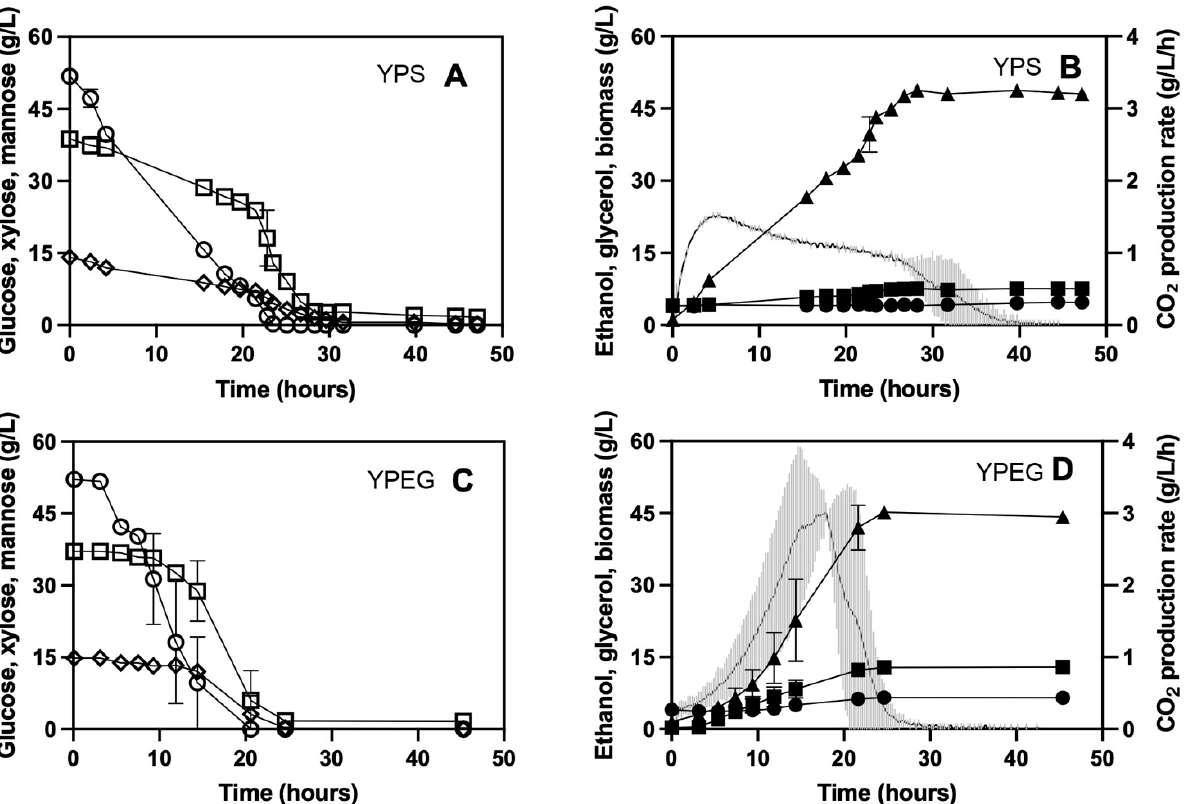
Figure 1. Substrate consumption and product formation over the course of 48 h of fermentation using ( A , B ) YPS cells and ( C , D ) YPEG cells. Glucose ( ), xylose ( ), mannose ( (cid:3) ), ethanol ( (cid:78) ), glycerol ( (cid:4) ), biomass ( • ), and CO 2 (—). Standard (cid:35) (cid:51) deviations derived from two independent experiments are indicated by error bars. For the fermentations using YPS cells, metabolite samples were taken at different timepoints for each duplicate, which means that standard deviations are only available for selected data points. The CO 2 exhaust was continuously monitored during all fermentations, and it is an indicator of the overall sugar conversion rate. The grey shadow depicts the standard deviation of the CO 2